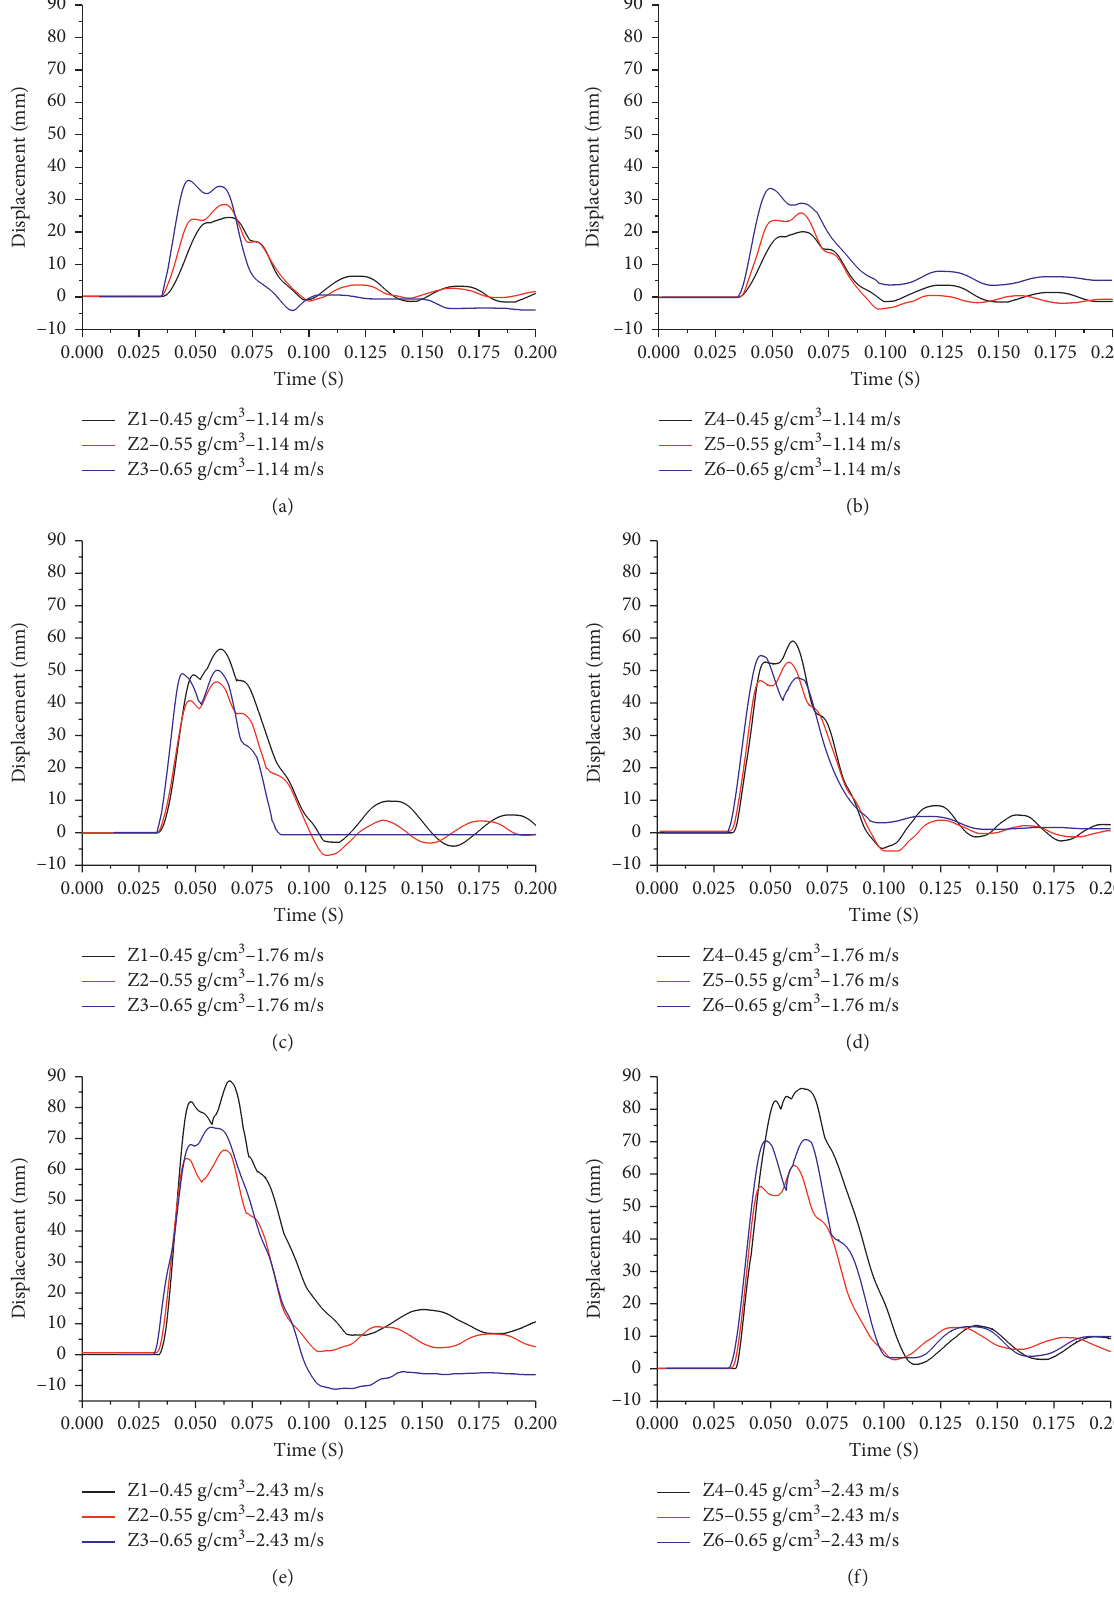
Figure 11: Top displacement time history